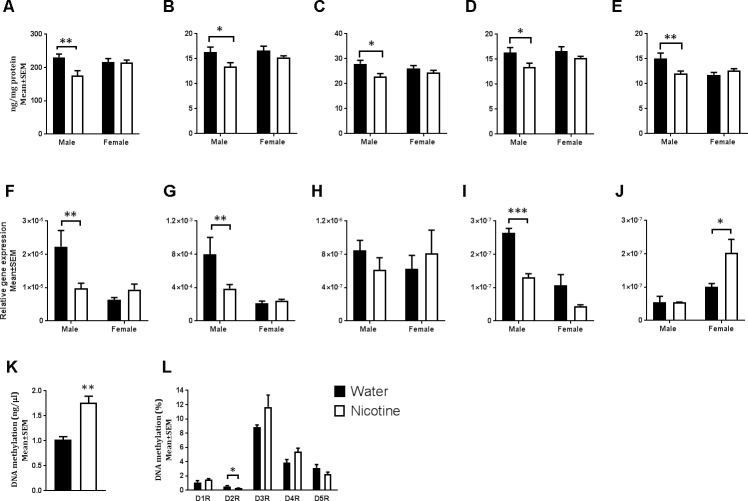
Tissue neurotransmitter content, striatal gene expression, and methylation of spermatozoal DNA.(A) Dopamine and its metabolites (B) DOPAC, (C) HVA, and (D) 3-MT in the striatum and (E) noradrenaline in the frontal cortex were measured (F1 water male n = 6; F1 nicotine male n = 6; F1 water female n = 6; F1 female nicotine n = 6). Striatal dopamine D1 (panel F), D2 (panel G), D3 (panel H), D4 (panel I) and D5 (panel J) receptor mRNA expression (F1 water male n = 3–5; F1 nicotine male n = 4–5; F1 water female n = 4; F1 female nicotine n = 4). Data were analyzed by two-way ANOVA. When main effect or interaction was significant, the ANOVA was followed by Bonferroni post hoc test. Asterisks for post hoc comparisons ***p < 0.001, **p < 0.01, *p < 0.05. Global DNA methylation (panel K; F0 water n = 4; F0 nicotine n = 4) and methylation of dopamine receptor promoter regions (panel L; F0 water n = 3–4; F0 nicotine n = 4–5) in spermatozoa of F0 founders was analyzed by Student unpaired t test, **p < 0.01, *p < 0.05 (panel K–L); S2 Data. 3-MT, 3-methoxytyramine; DOPAC, 3,4-dihydroxyphenylacetic acid; HVA, homovanillic acid.